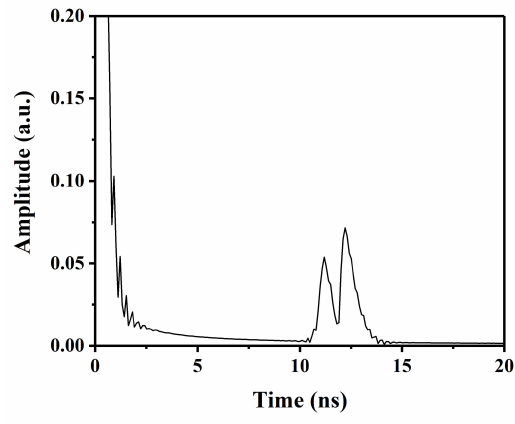
Figure 10. Detection results of 2 fault